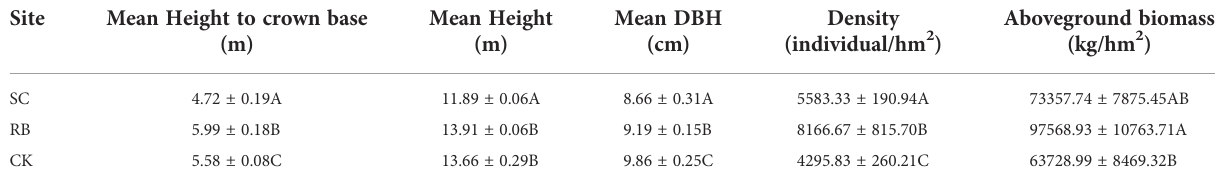
Values are the mean ± standard deviation (n = 3). Different capital letters indicate that there are signi fi cant differences in stand characteristics and aboveground biomass in different treatment plots (ANOVA and LSD test, p <